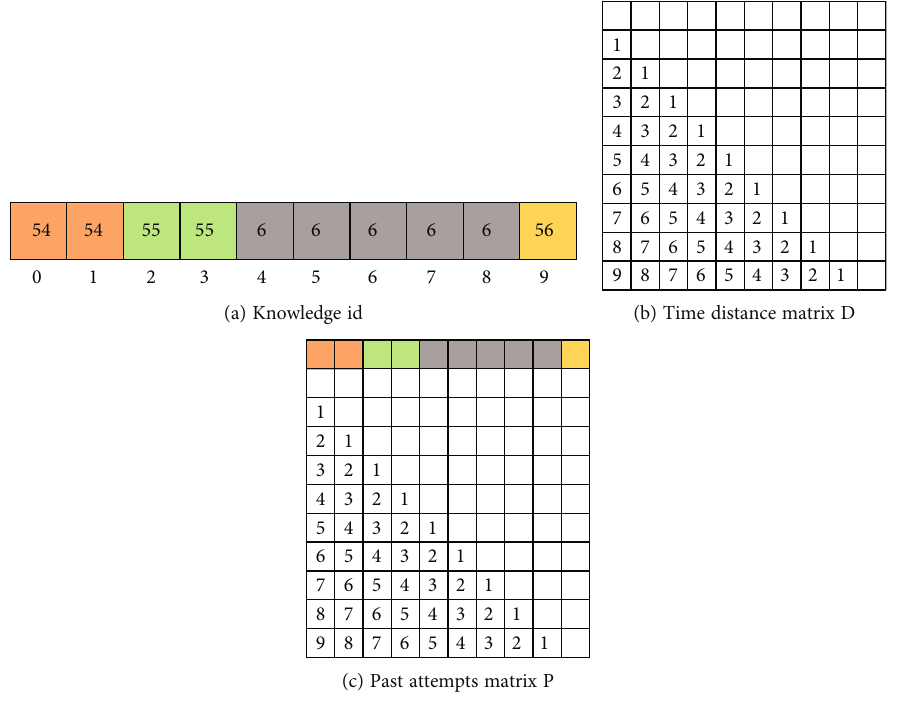
Figure 2: Forgetting factor matrices.